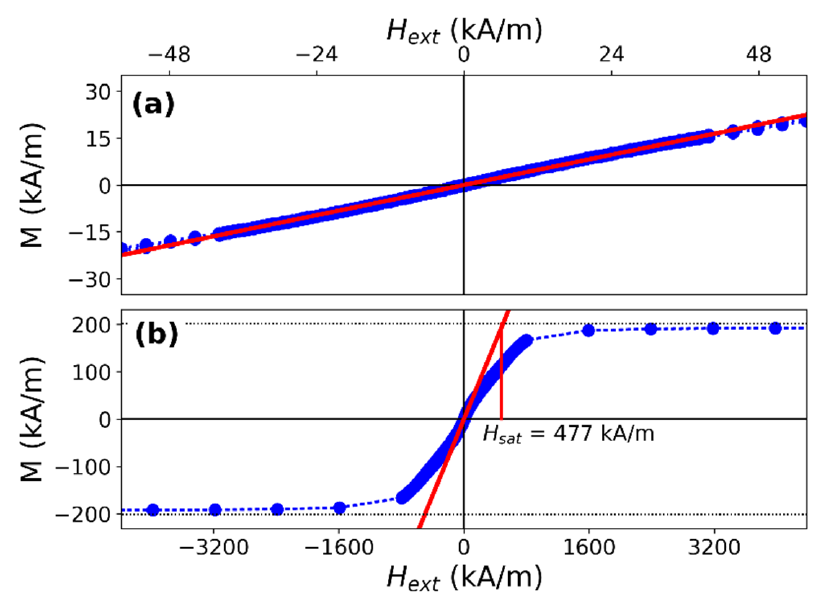
Figure A4. VSM measured M-H curves of the Ti/Pt/Co reference sample: ( a ) shows a zoomed-in version of ( b ). The red line shows the fit to the low-field linear part of the curve; ( b ) also shows the construction of the µ 0 H sat value from the intersection of the fit with M = M sat .